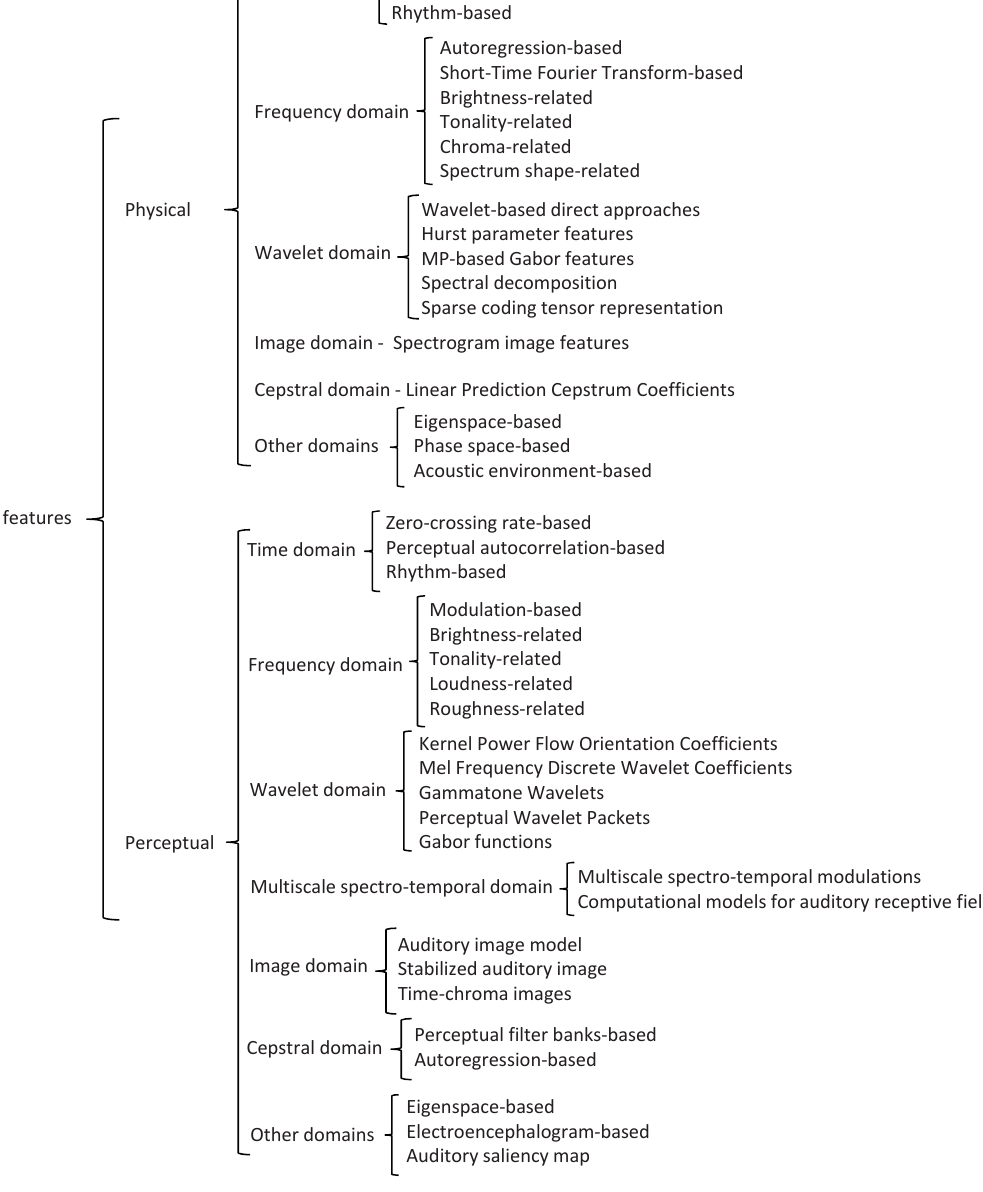
Figure 5. Taxonomy of physical vs. perceptual based audio features extraction